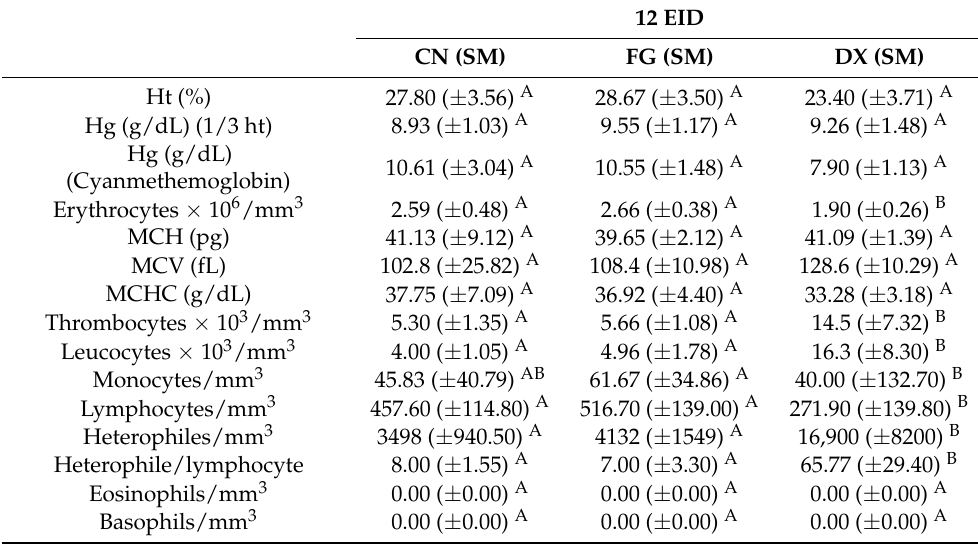
Table 6. Blood cell count in CE treated with FG and DX at 12